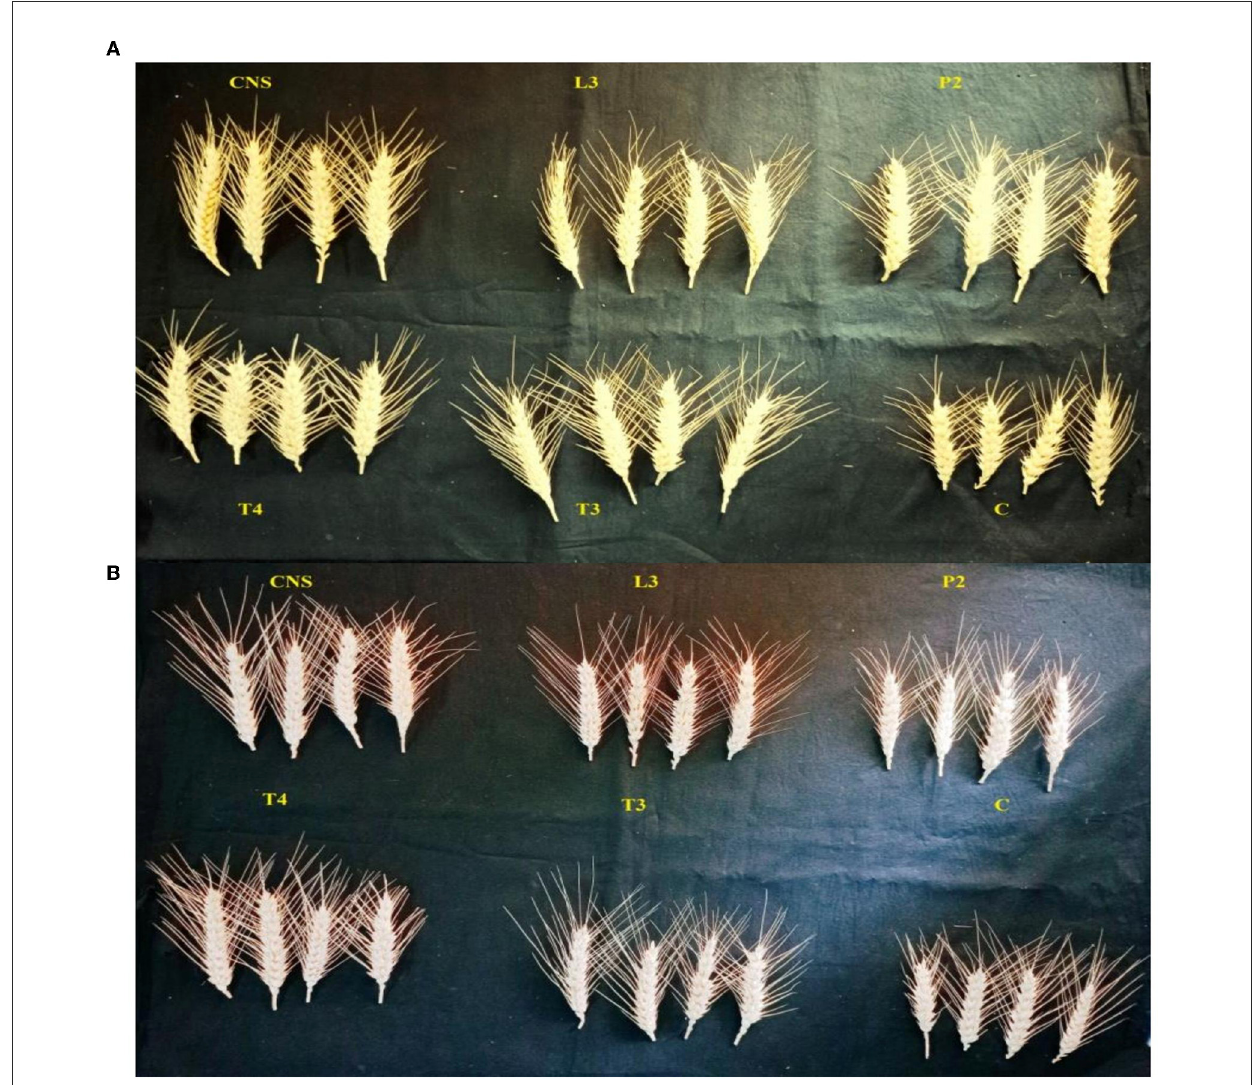
FIGURE6 Grain per spike (GPS) variation in different PSB treatments in the field set 1 (PSB + RDF) (A) and field set 2 (PSB – RDF) (B) .